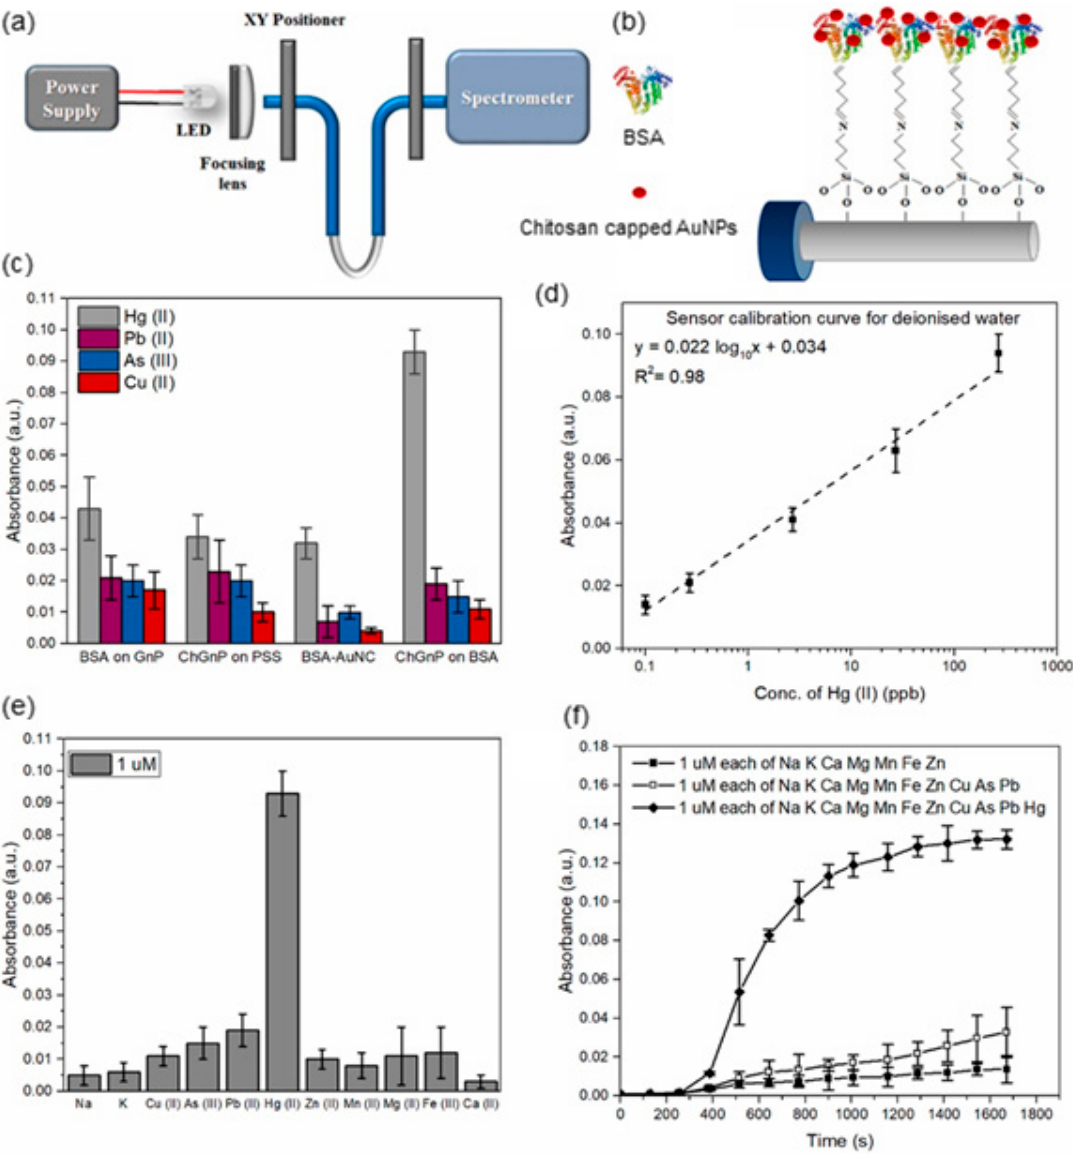
Figure 15. ( a ) The schematic illustration of the detection system. ( b ) Functionalization of